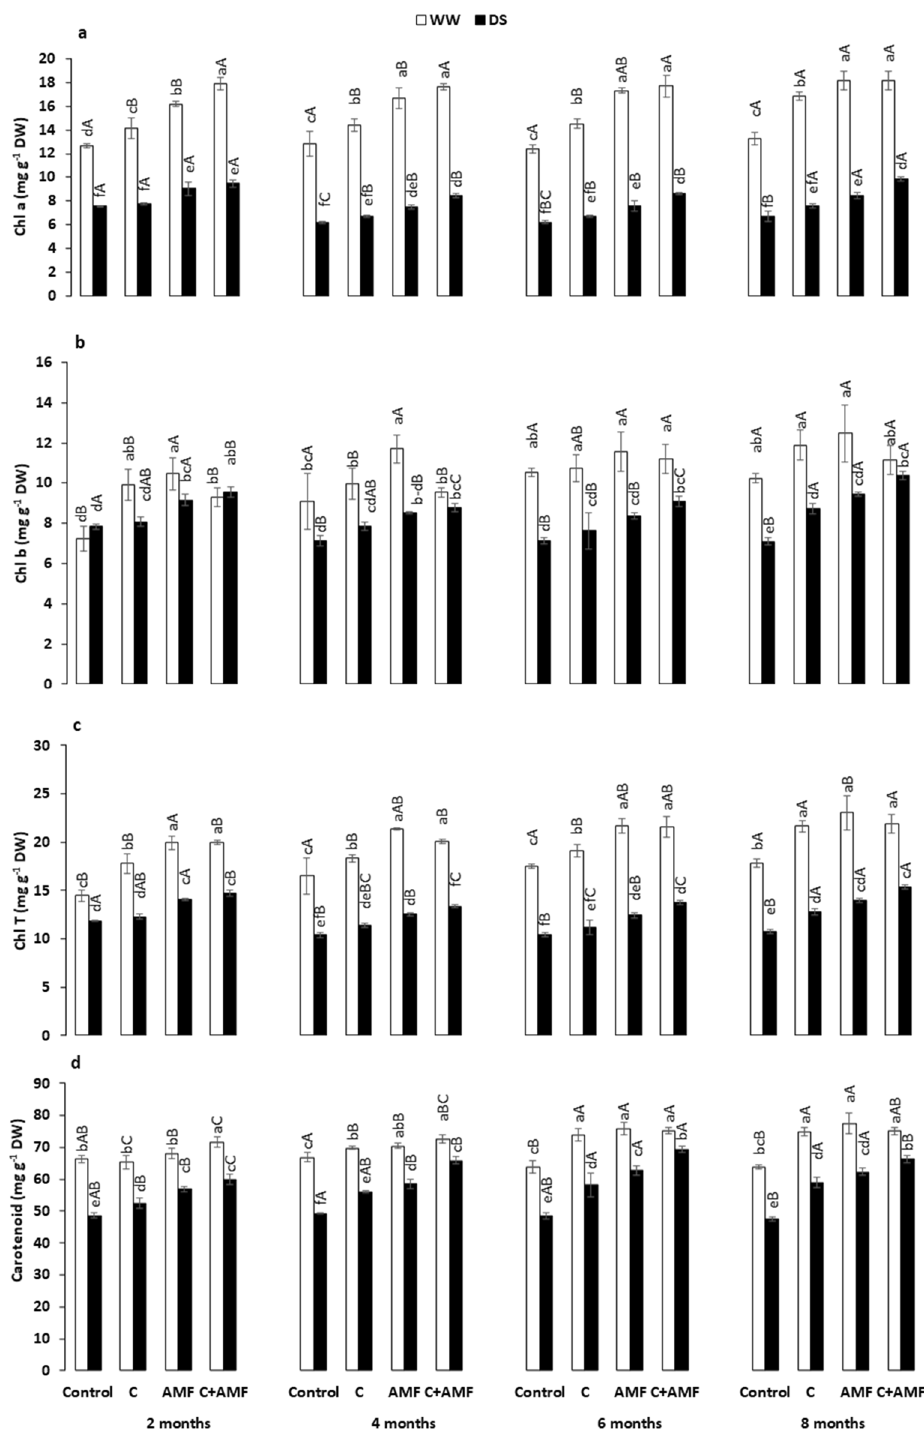
Figure 4. Effects of water regimes (WW: well-watered; open bars and DS: drought stress; filled bars) on ( a ) chlorophyll-a; chl ‘a’, ( b ) chlorophyll-b; chl ‘b’, ( c ) total chlorophyll; chl ‘T’, and ( d ) carotenoid in control carob plants and plants amended with compost (C) and/or assemblage of indigenous arbuscular mycorrhizal fungi (AMF). Data are mean ± SE (n = 5). Means followed by the same letters within the same time point are not significantly different at P < 0.05 (Tukey’s HSD). The upper case represents the differences within WW or DS water regime, and the lower case represents the differences within a one-time